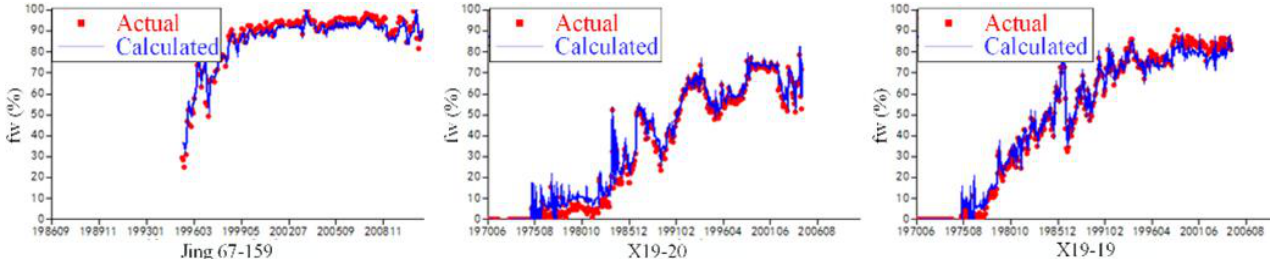
Figure 9—Comparison of calculated and designed water cut of wells.